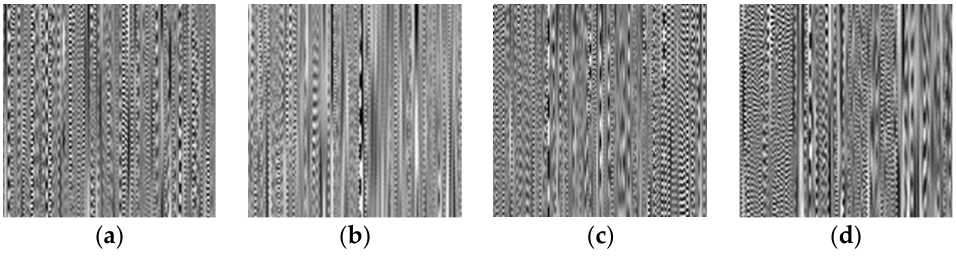
Figure 9. Example of grayscale image. ( a ) Switch; ( b ) Seam; ( c ) Damage; ( d ) Normal.